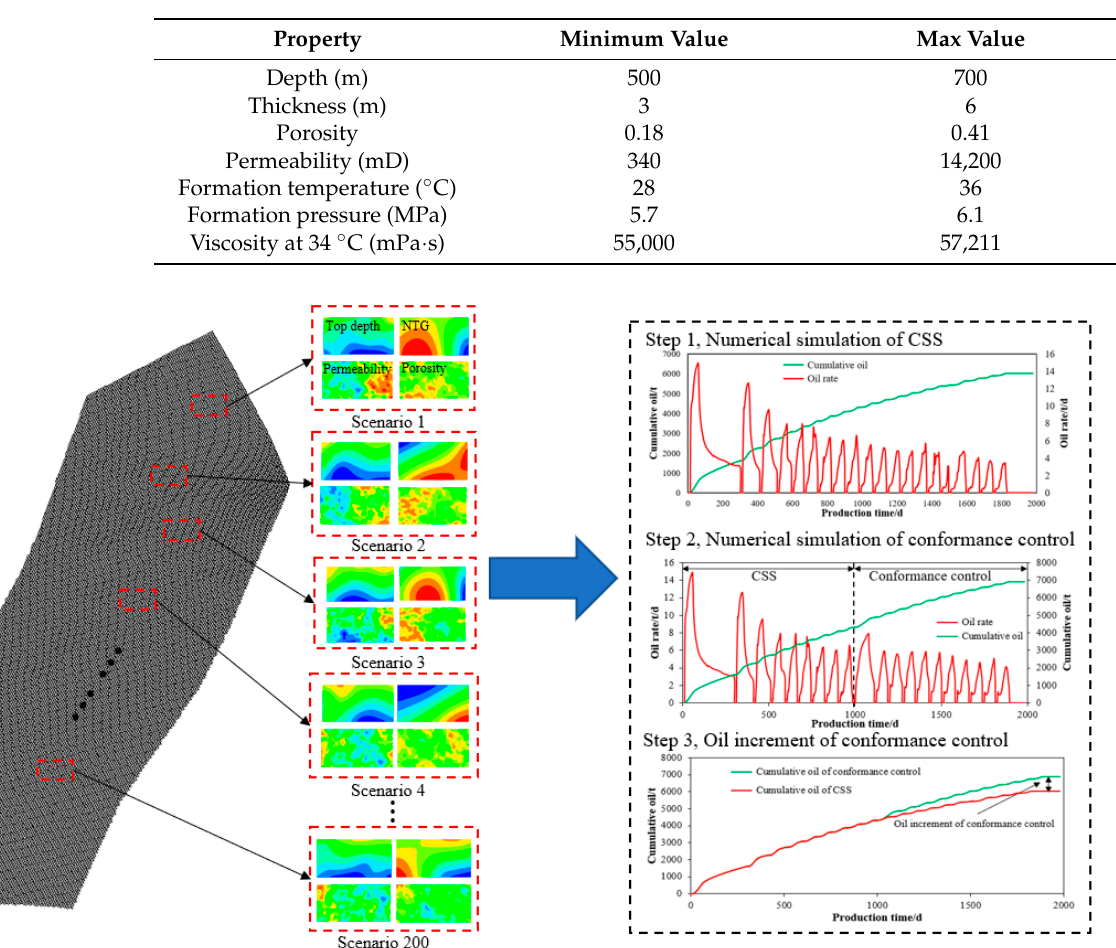
Table 1. The properties of the Southern P601 block in the Chunfeng Oilfield.